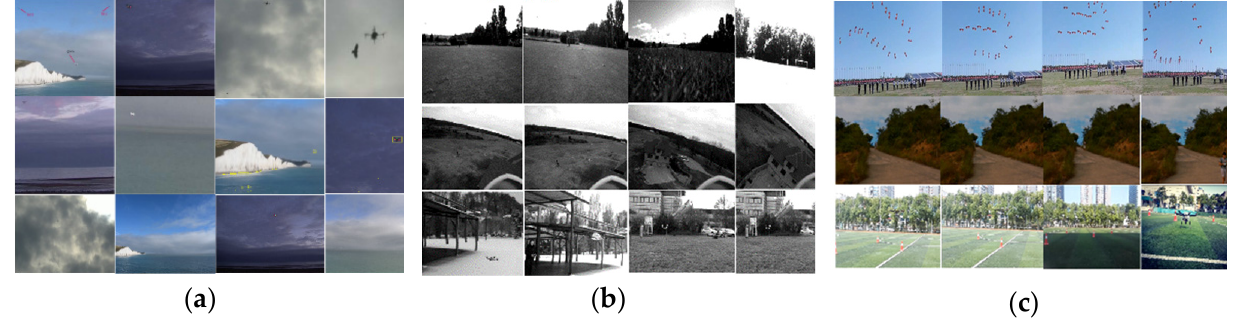
Figure 7. Example images in MUD dataset. ( a ) Drone-vs-Bird Dataset. ( b ) UAV-Aircraft Dataset. ( c ) Self-collected data.